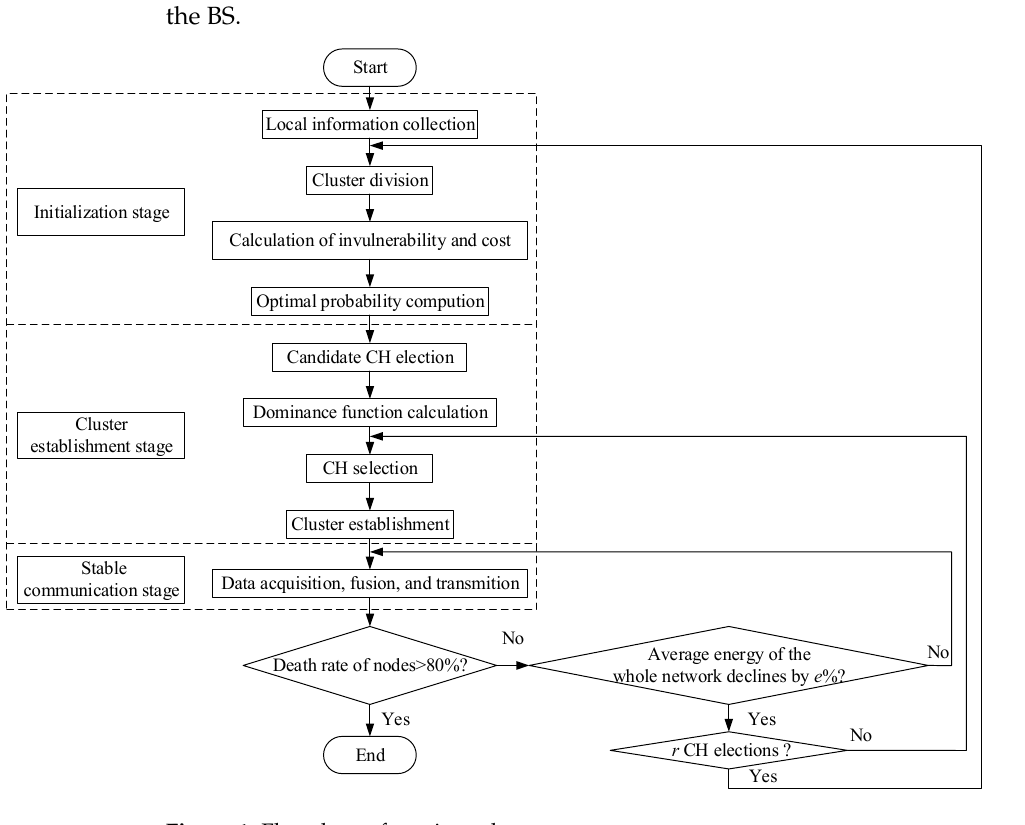
Table 3. Initial setting of simulation parameters.